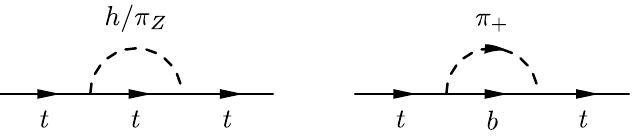
Figure 7: One-loop corrections to the top wave-functions to